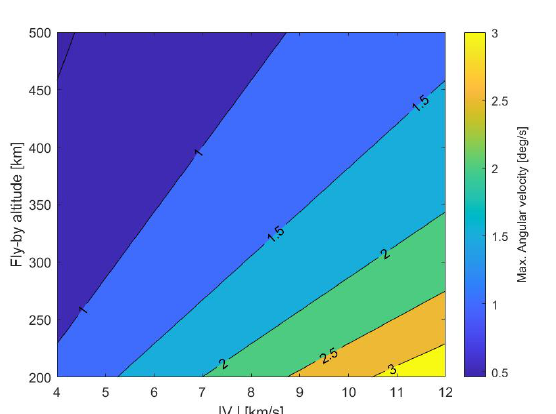
Figure 6. Relative angular velocity at the closest approach in function of the fly-by altitude and relative